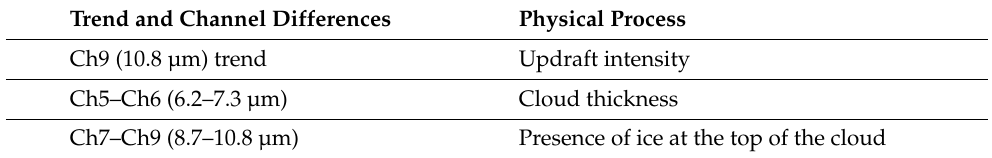
Table 1. Useful channels for cloud development